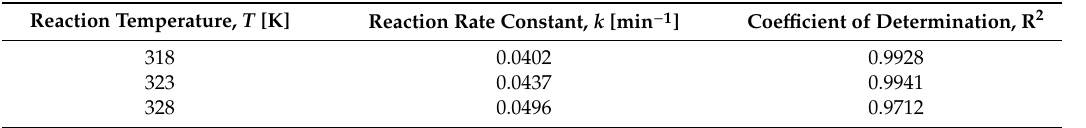
Table 8. Determination reaction rate constants and coefficients from the [1 − (1 − a ) 1 − 1.1 ]/ (1 − 1.1) versus time plot.